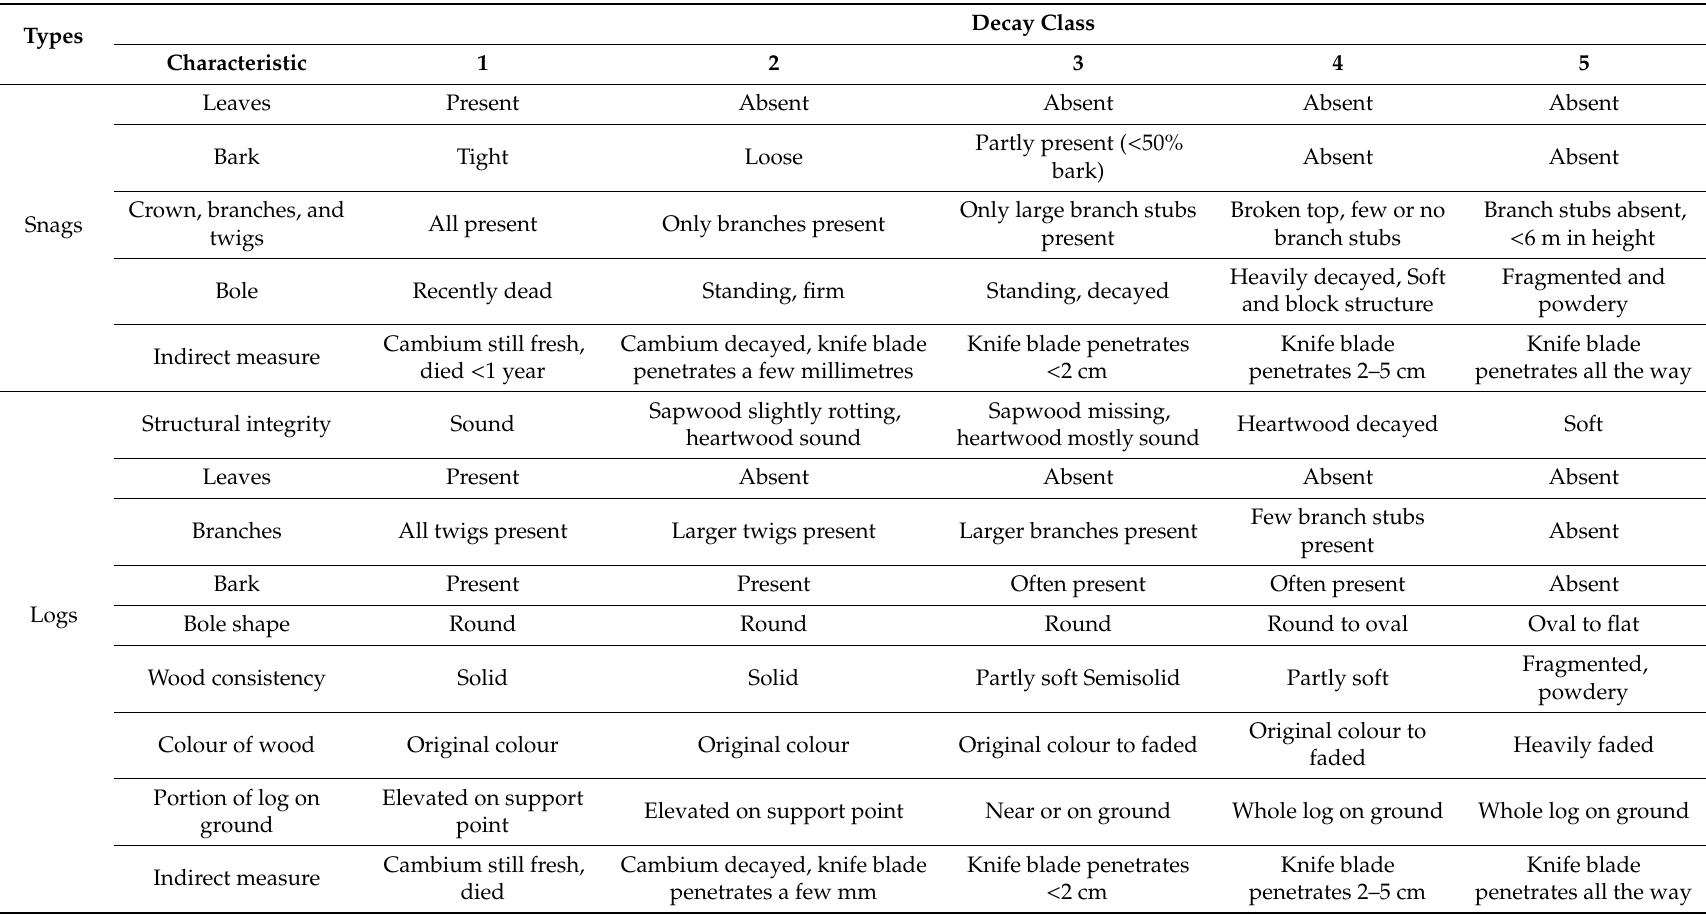
Table 1. Classification system of snags and downed logs in decay classes (Modified by Behjou et al.